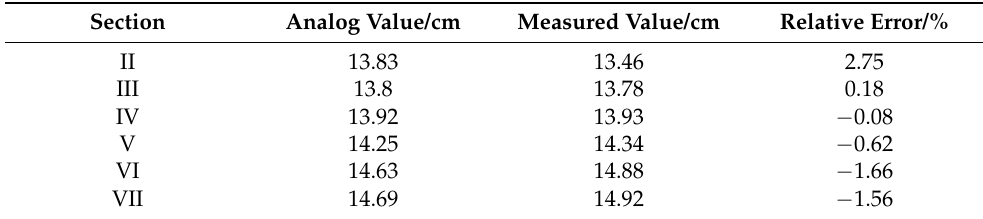
Table 1. Analysis of the relative error of water depth in different sections at the flow rate of 40 L/s and the branch channel width of 36 cm.